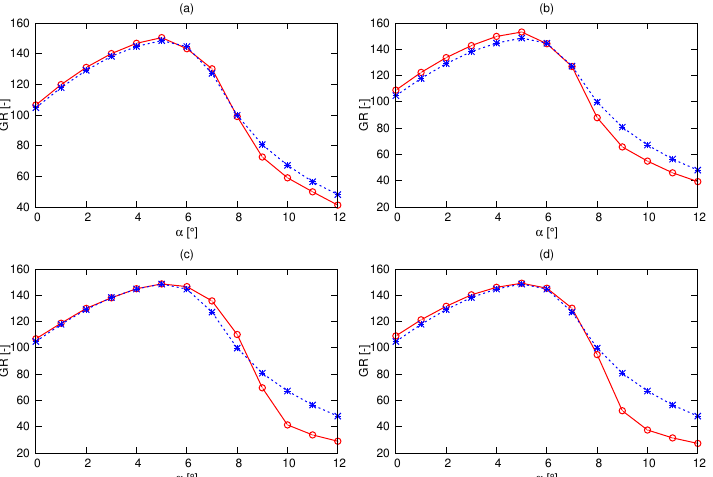
Figure 10. GR of the reference and optimized hydrofoils of the second case of 3-D optimization, where ( a ) is GR of HF-3D-2-1, ( b ) is GR of HF-3D-2-2, ( c ) is GR of HF-3D-2-3 and ( d ) is GR of HF-3D-2-4. The red and blue lines denote optimized and reference,respectively.